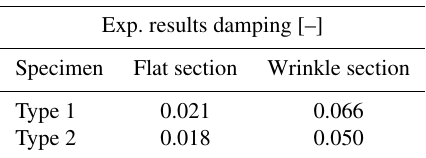
Table 3. Experimental damping values for specimens type 1 and type